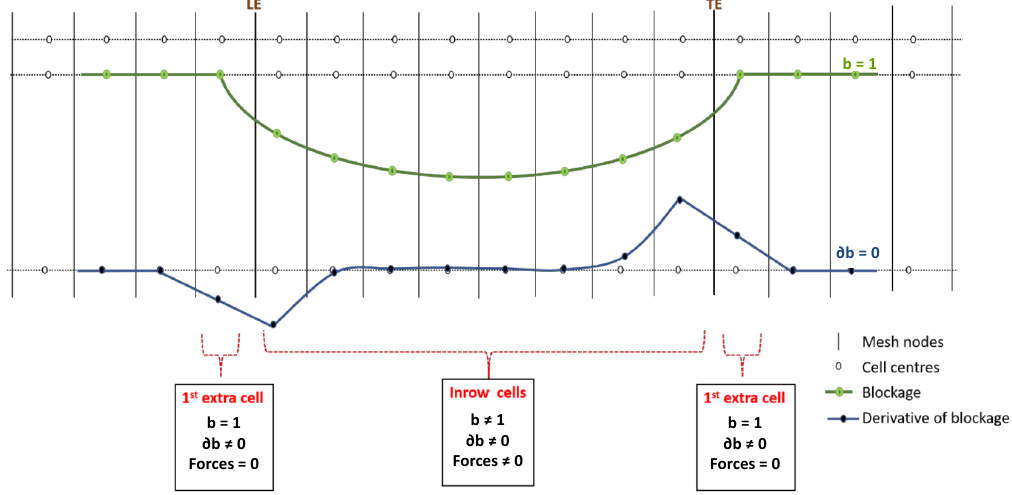
Figure 7. 1D representation of blockage and its